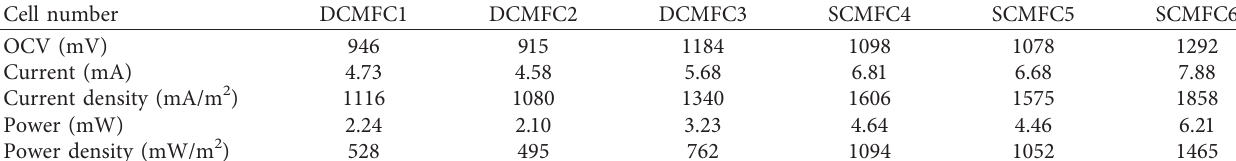
Table 4: Electrical parameters of DCMFCs and SCMFCs.